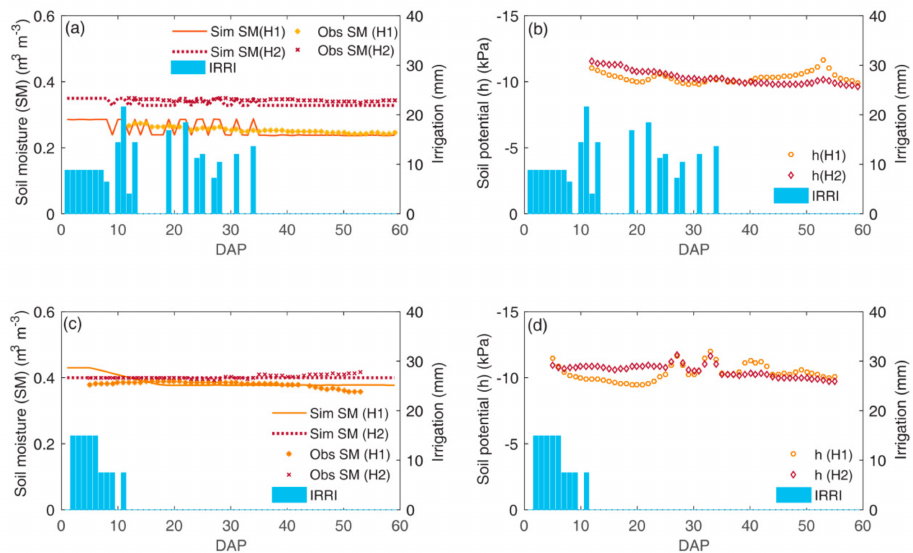
Figure 7. Simulated soil moisture and observed soil moisture data measured at depths of 5 cm (H1) and 15 cm (H2) using soil moisture sensor 10HS and soil potential MPS-2: ( a ) soil moisture at site S1; ( b ) soil potential at site S1; ( c ) soil moisture at site S2; ( d ) soil potential at site S2. DAP is day after planting, Sim SM is simulated soil moisture, Obs SM is observed soil moisture, IRRI is irrigation, h is soil